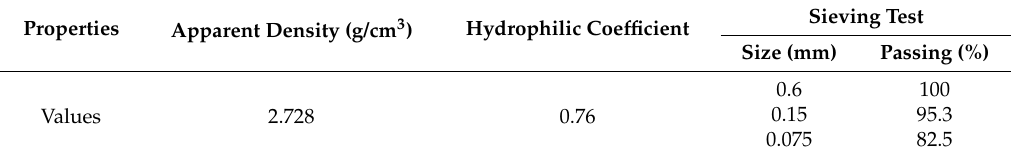
Table 3. Physical properties of the limestone powder.